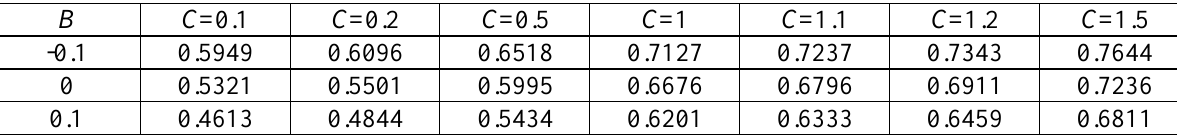
¢- with C and B (K=1,